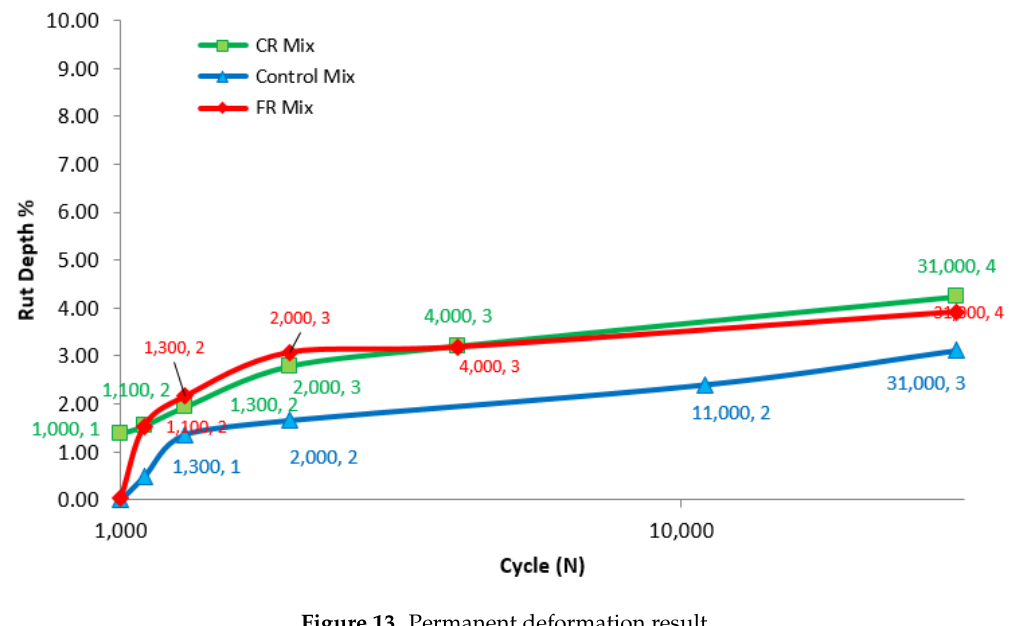
Figure 14. RAP mix slabs after rutting test. A single sample of each mix type was adopted for permanent deformation validation. Basically, the first 1000 preconditioning cycles (aka cold runs) are assumed to capture the continued consolidation stage. There was a significant difference between FRM and CRM mixes. The rest of loading was performed at 60 °C. In addition, the binder exhibits a softer response at 60 °C than the cold cycles temperature. This difference in rutting might be caused by impact of aggregate gradation and air void content. After 1000 hot cycles (post compactions), FRM was deformed almost as same as CRM. Both RAP mixes deformation were two times higher than control mix. This section could be characterized by S1 and S2. Parameter “S” represents the slope of the permanent deformation in Figure 13. For the FRM and the control mix, rut depth dramatically increased at first 300 cycles (S1) and continued at a constant slop, whereas for the CRM, these slopes increased at the same rate in both steps (i.e., S1 and S2). The last stage represents the reaction of material to wheel passes loading which can be translated as rutting values. Table 3 shows the slop per section of rutting test. It can be seen that the CRM and control mix responded the same way to the load in rutting section, which was two times higher than FRM (see S4 in Table 3). The aggregate gradation plays the main role in rutting resistance. In this study, black curve was kept the same in all mixes.